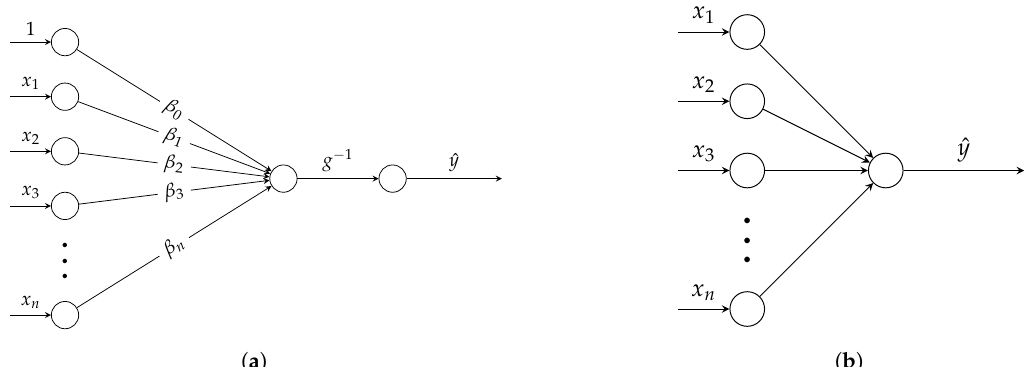
Figure 5. Visualizing a GLM in a neural network graph diagram. ( a ) Graph in GLM notation. ( b ) Graph in NN notation.